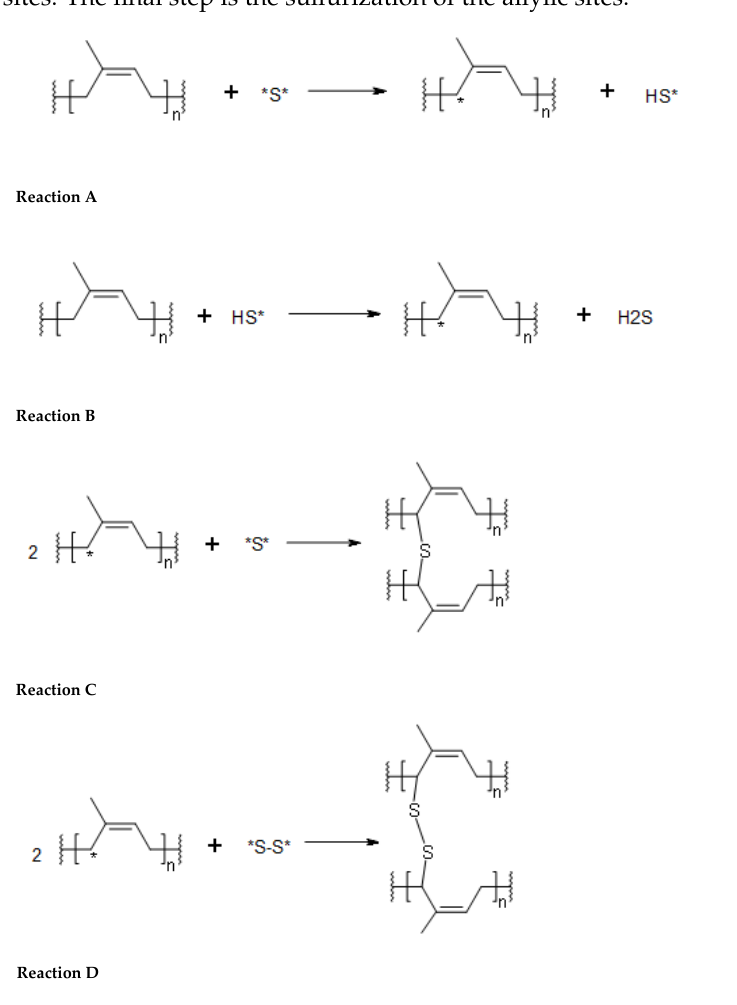
Scheme 1. The reactions A , B , C , D leading to crosslinks between isoprene units sulfur diradical spe- cies connecting adjacent rubber chains with sulfur bridges crosslinks. ( Reaction A )